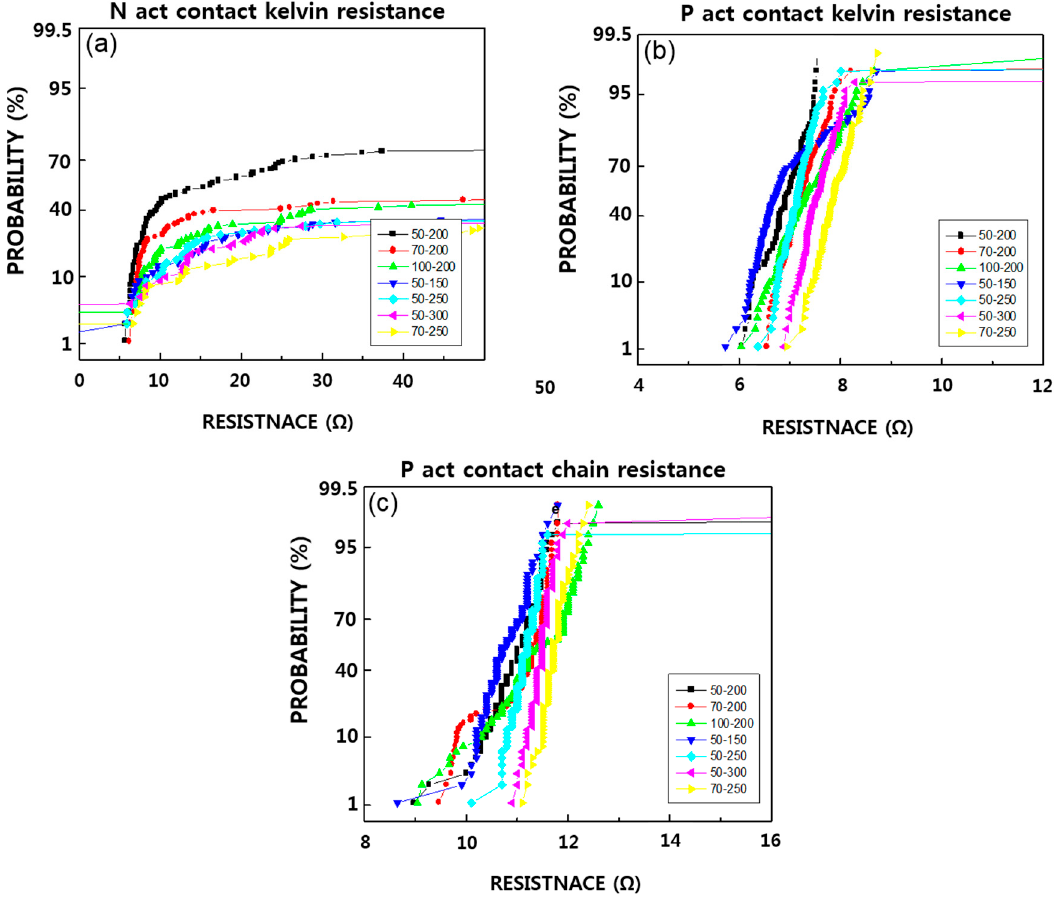
Figure 4. Result of ( a ) N act kelvin, ( b ) P act kelvin, ( c ) P act chain contact resistance by process conditions (unit: Å).